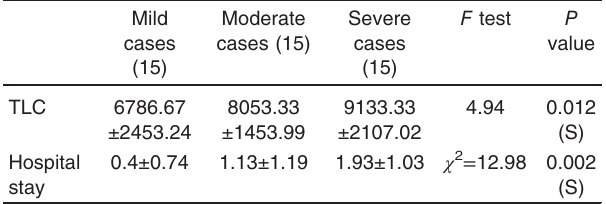
Table 4 Comparison between the studied groups according to total leukocytic count and hospital